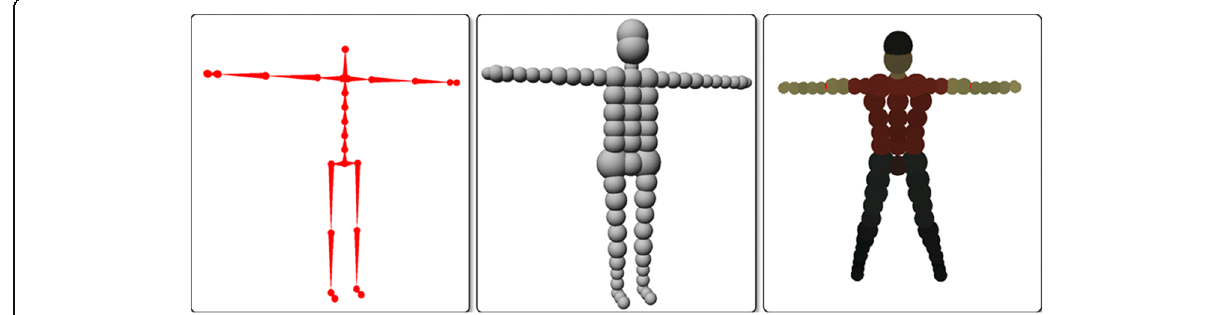
Fig. 4 Sum of Gaussian body model from Stoll [75]. A skeleton (left) forms the foundation of the model, providing limb-lengths and body pose. The body is given volume and appearance information through the use of 3D Spatial Gaussians arranged along the skeleton (represented by spheres). The resulting information allows the model to be fit to image data